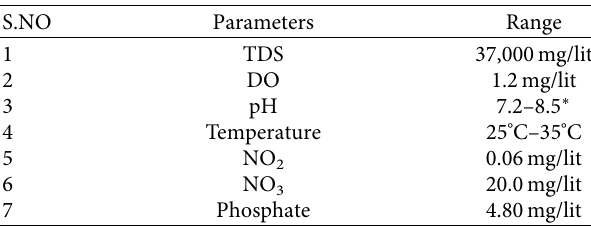
Figure 6: Initial soak Effluent for treating wastewater by seaweeds. Table 1: Characteristics of sea water.